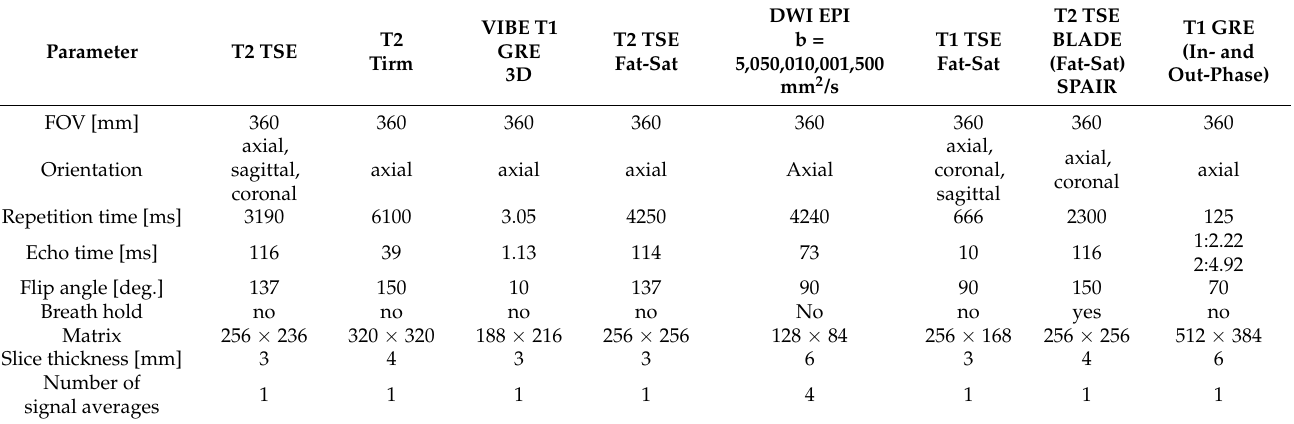
Table 3. Some of the parameters of the 1.5T Magnetic Resonance (Magnetom Avanto, Siemiens AG, Erlangen) used in the